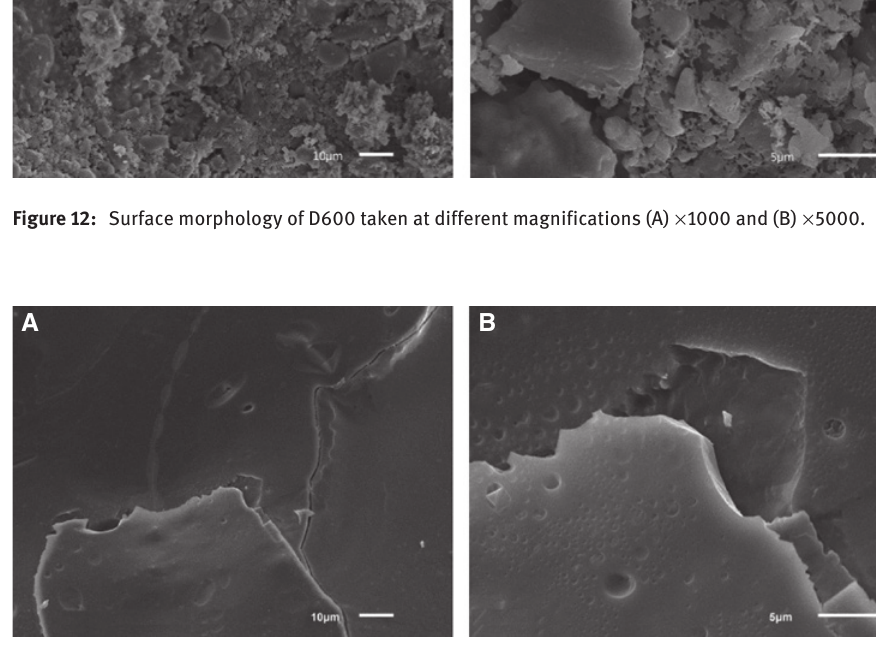
Figure 13: Surface morphology of D900 taken at different magnifications (A) × 1000 and (B) ×